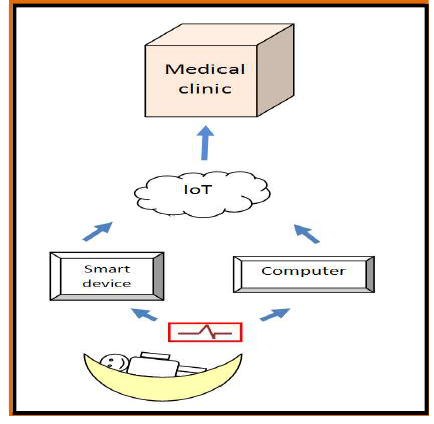
Figure 1. Monitoring architecture.